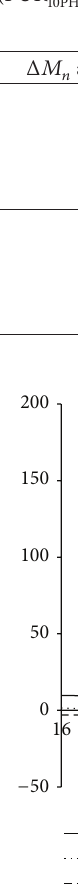
) and its blend (PUR /PLA) before and after incubation in PBS (4 20PHB+80PTMG 20PHB+80PTMG